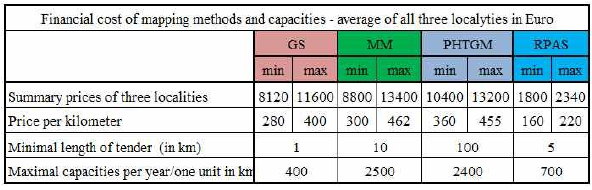
Table 2. Comparison of the mapping methods as for